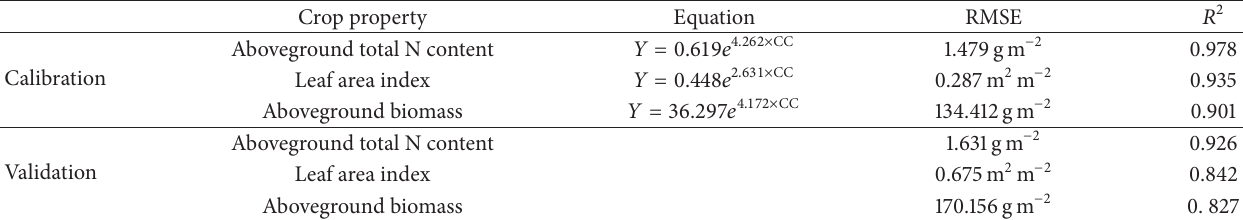
Table 5: Fitted parameters and goodness of fit for calibration equations linking canopy cover in experiment 1 with aboveground total N content, LAI, and aboveground biomass using (1). Validation refers to the goodness of fit for the three equations applied to canopy cover measured at three sites in experiment